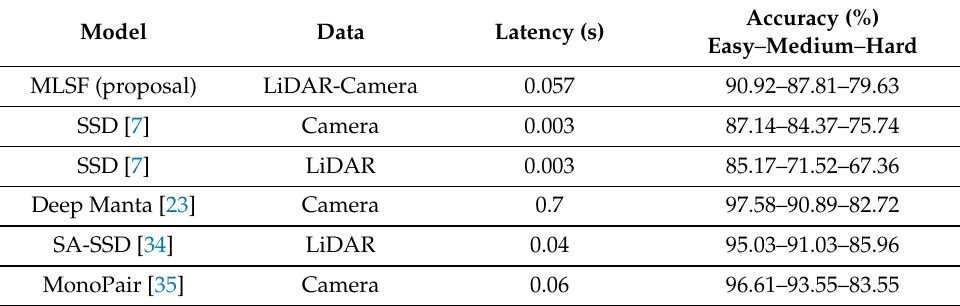
Table 3. Comparison of of our model with no-sensor fusion algorithms.